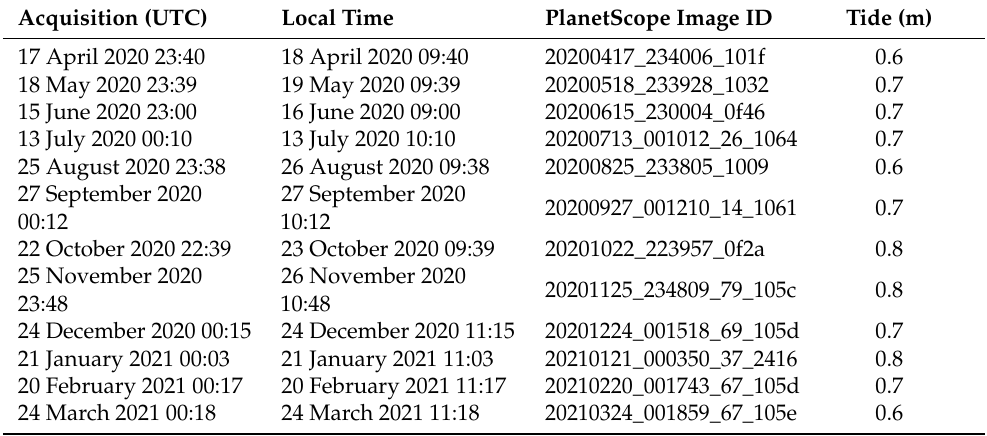
Table 3. Monthly PlanetScope images used in this study with tide level (m) at time of acquisition. Acquisition (UTC) Local Time PlanetScope Image ID Tide